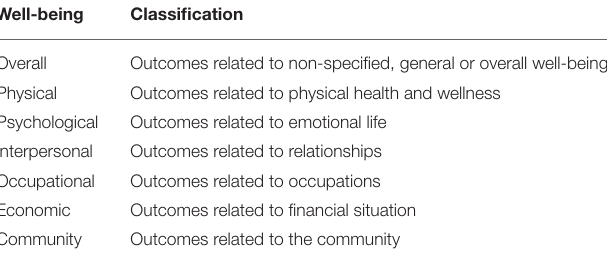
TABLE 1 | Keywords constituting the syntax entered in the databases. Included